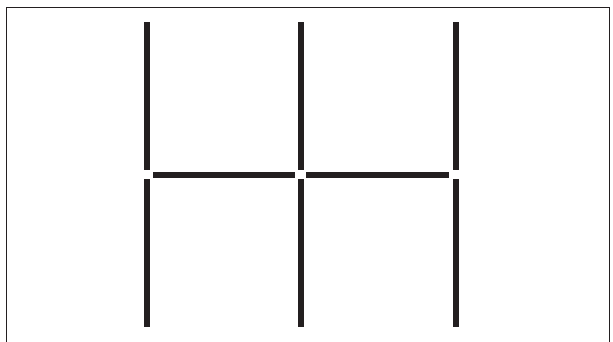
FIGURE 1: A simple geometrical figure.